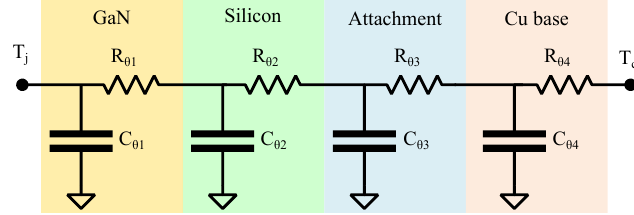
Figure 4. Equivalent thermal model of a GaN